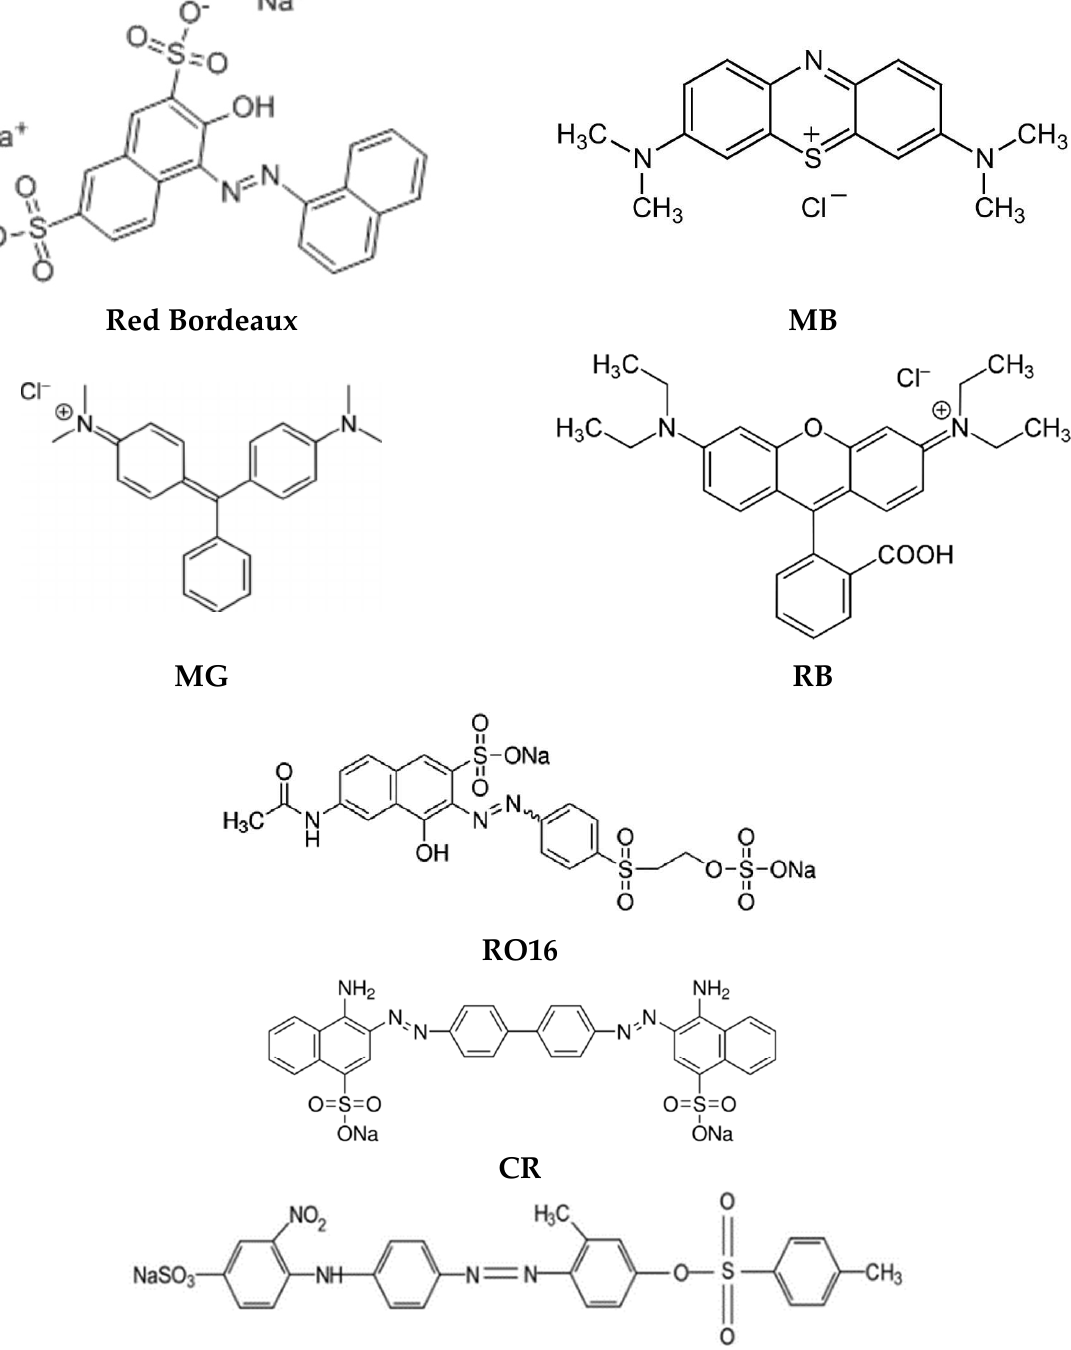
Figure 3. Structures of synthetic dyes removed by PIMs. Table 3. Examples of removal of synthetic dyes by various PIMs.